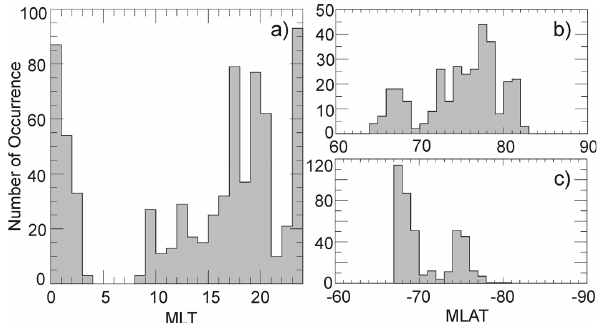
Fig. 3. Histogram distributions of the magnetic local times (panel (a) ) and ACCGM magnetic latitudes (panels (b) and (c) for the Northern and Southern Hemispheres, respectively) for SuperDARN echoes selected for a comparison with DMSP